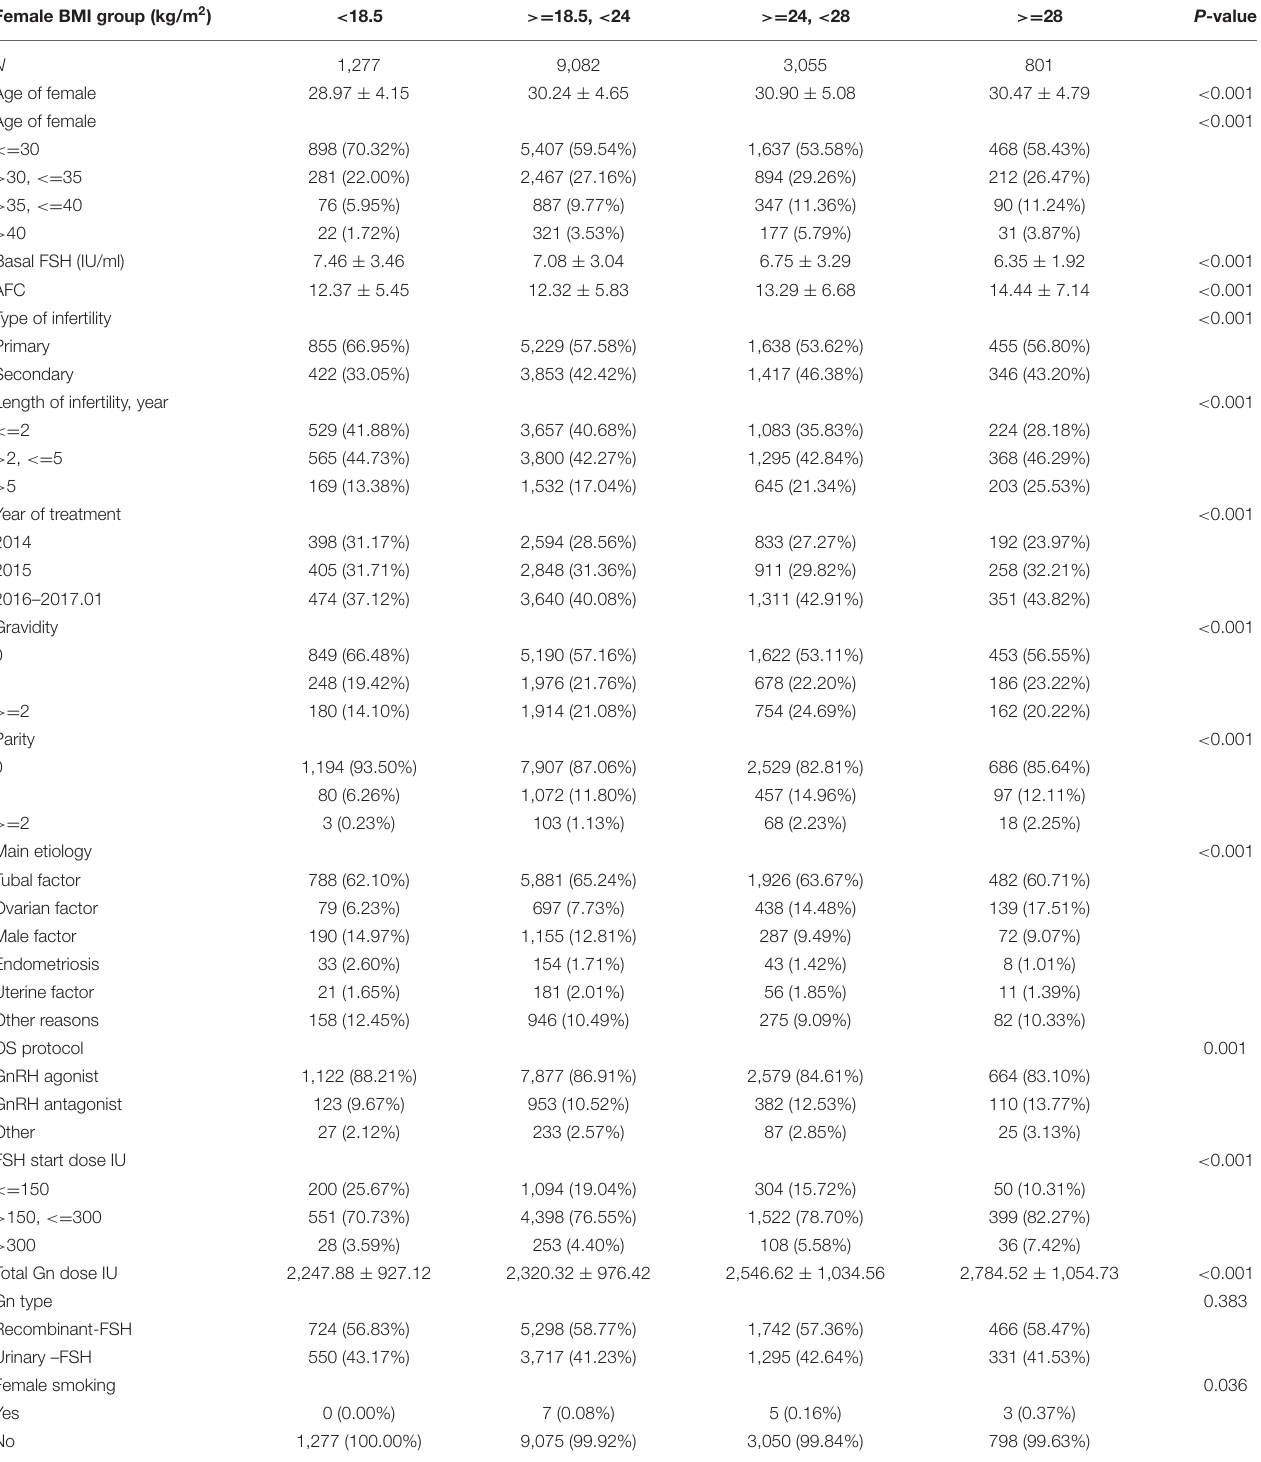
TABLE 1 | Demographics and basal